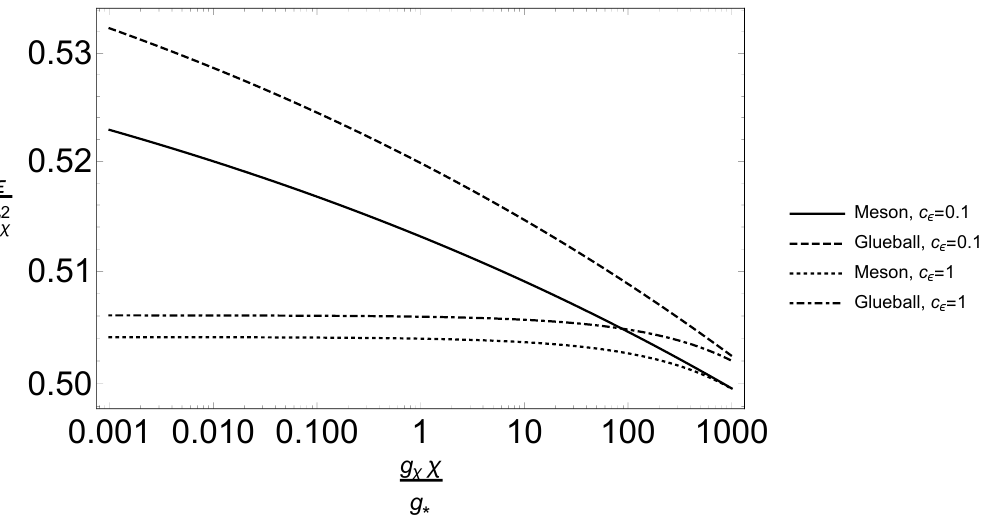
Figure 7 . The function (cid:15) [ (cid:31) ] for a glueball-like and a meson-like dilaton with m (cid:31) = 500 GeV, N = 5 and di(cid:11)erent values of c (cid:15) . The variable g (cid:31) (cid:31)=g ? on the x-axis was chosen to ensure that the functions for the meson-like and glueball-like dilaton (cid:12)t on the same plot.